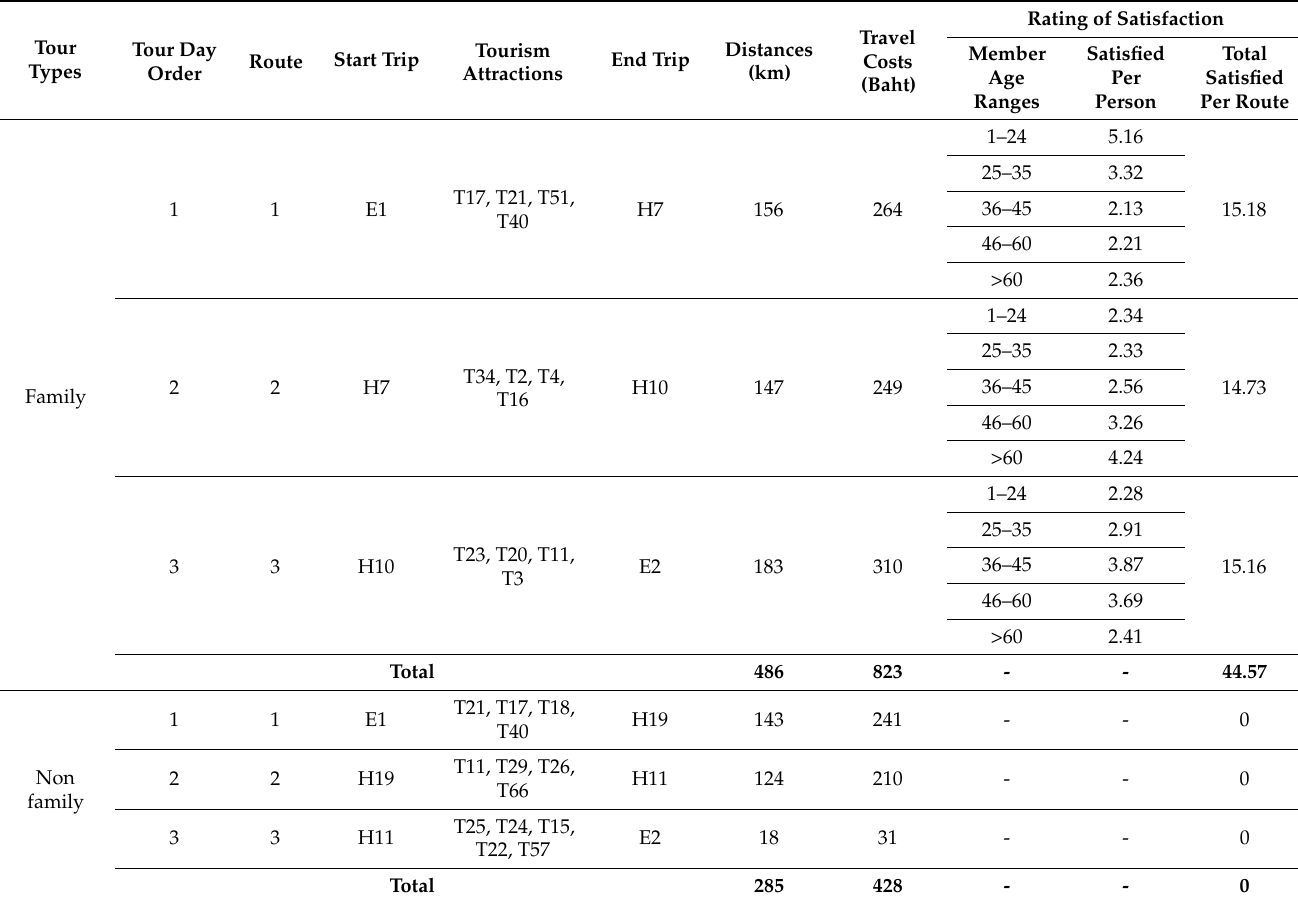
Table 8. Case study results for family tourism and non-family